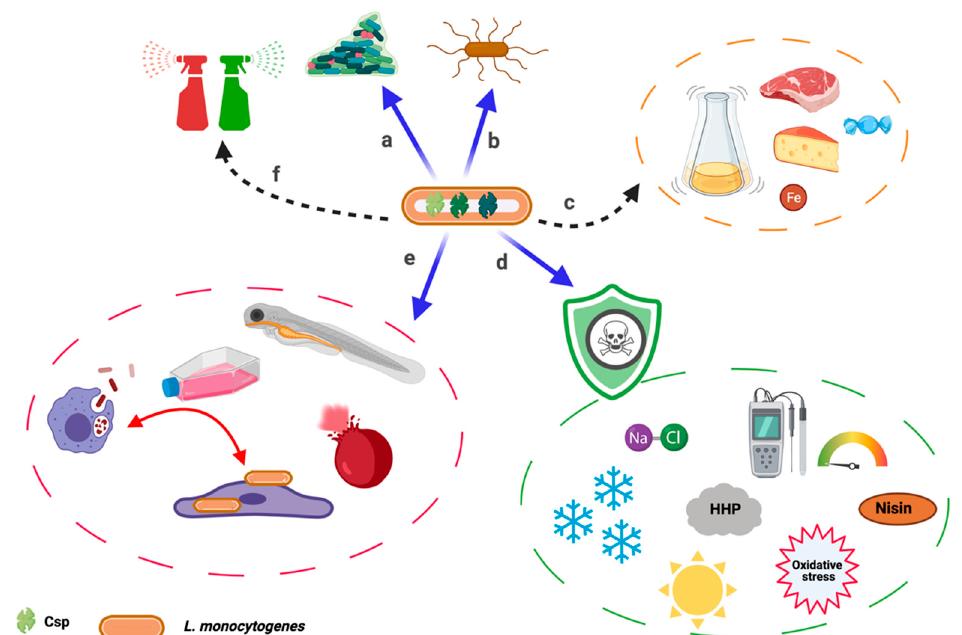
Figure 2. Overall effects of cold shock proteins (Csps) in L. monocytogenes : Csps are involved in ( a ) biofilm formation, ( b ) motility through impacting flagella expression, ( c ) they are dispensable during normal growth at optimal temperature. However, current data and inference from other bacterial species suggest that Csps are involved in nutrient acquisition and utilization. Nevertheless, this needs to be confirmed. ( d ) Csps are involved in stress tolerance responses to cold, osmotic, oxidative, high hydrostatic pressure (HHP), and desiccation stress. It is suggested that they might play roles in response to pH and bacteriocin (e.g., nisin) stress. However, this needs to be validated. ( e ) Csps are important for the full expression of virulence as observed in zebrafish embryos. They promote hemolysis, cell invasion, as well as growth and survival within macrophages. ( f ) Csps involvement in response to cleaning and disinfection chemical stress is yet to be confirmed, but inference from other bacterial species supports their involvement. Figure 2 was created with BioRender.com.